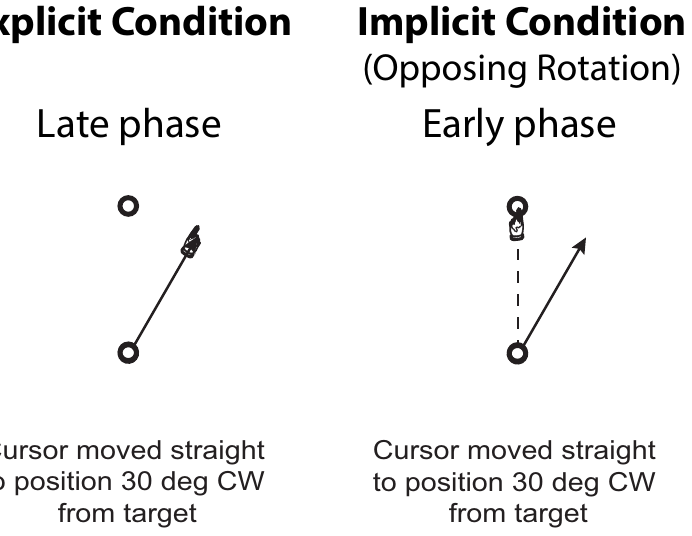
Fig 6. Experimental conditions for Exp-to-Imp/Opp group. In explicit condition, the same setup used in Experiment 1 was used. Solid black line with hand sign at the end indicates both cursor and hand movement directions. In implicit condition, subjects reached toward visual targets without knowing that the cursor was rotated 30 degrees CW about the start circle. In early phase, subjects reached straight toward the targets, while the cursor moved 30 degrees CW from the target. Solid black arrow indicates cursor movement direction; solid black line with hand sign at the end indicates hand movement